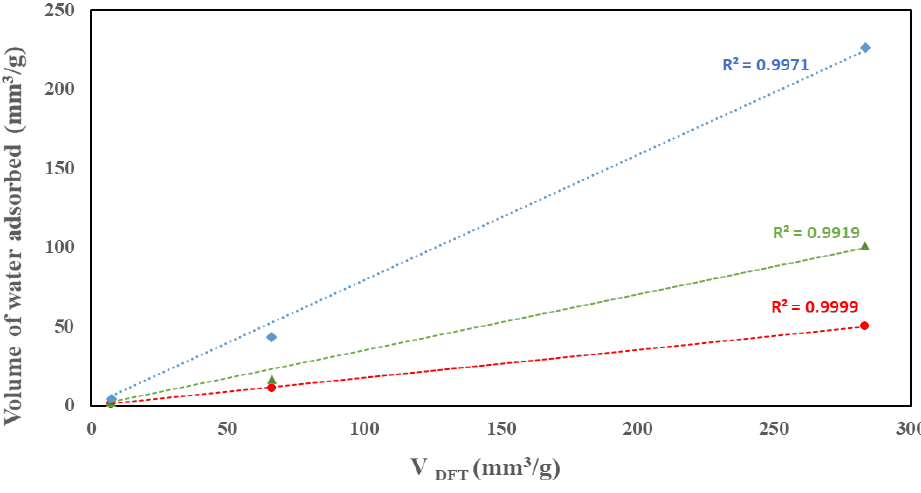
Figure 9. Correlation between the volumes of water adsorbed at different relative pressures and the total pore volume.